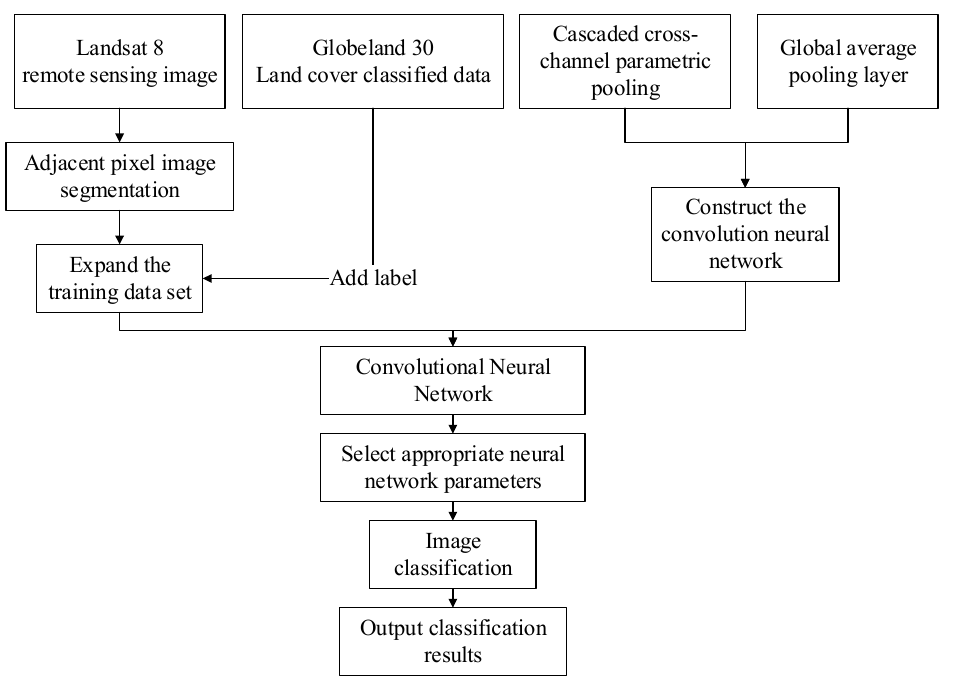
Figure 2. Flowchart of the land classification process using the deep convolutional neural network (DCNN) model.